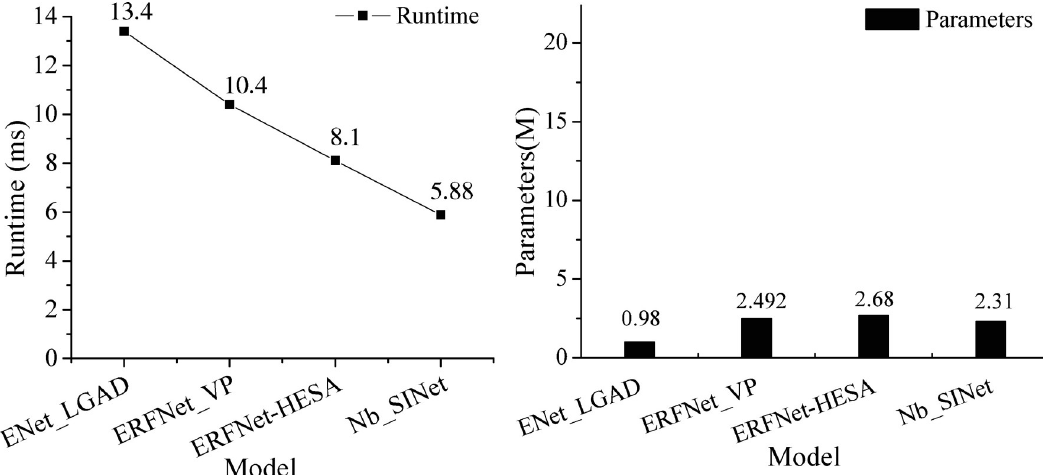
Fig 12. Comparison between the runtime and numbers of parameters for the tested models. (a) Comparison of runtimes. (b) Comparison of the number of parameters.